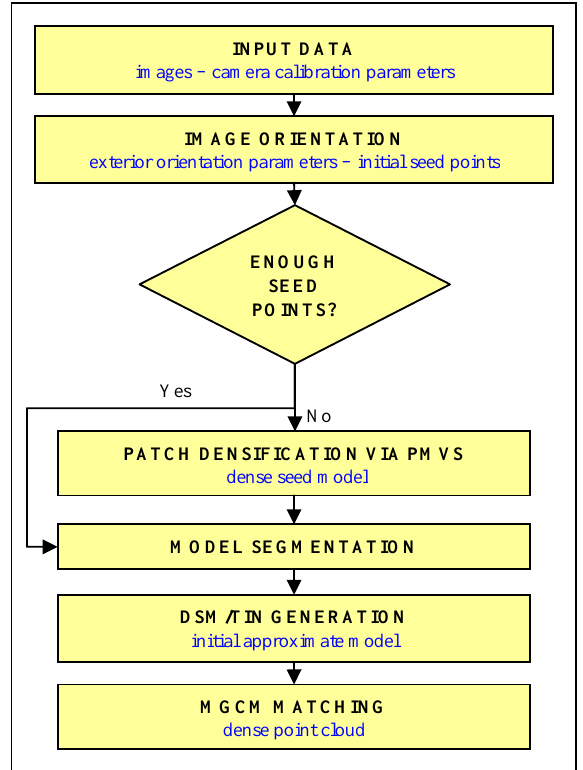
Figure 1. Workflow of